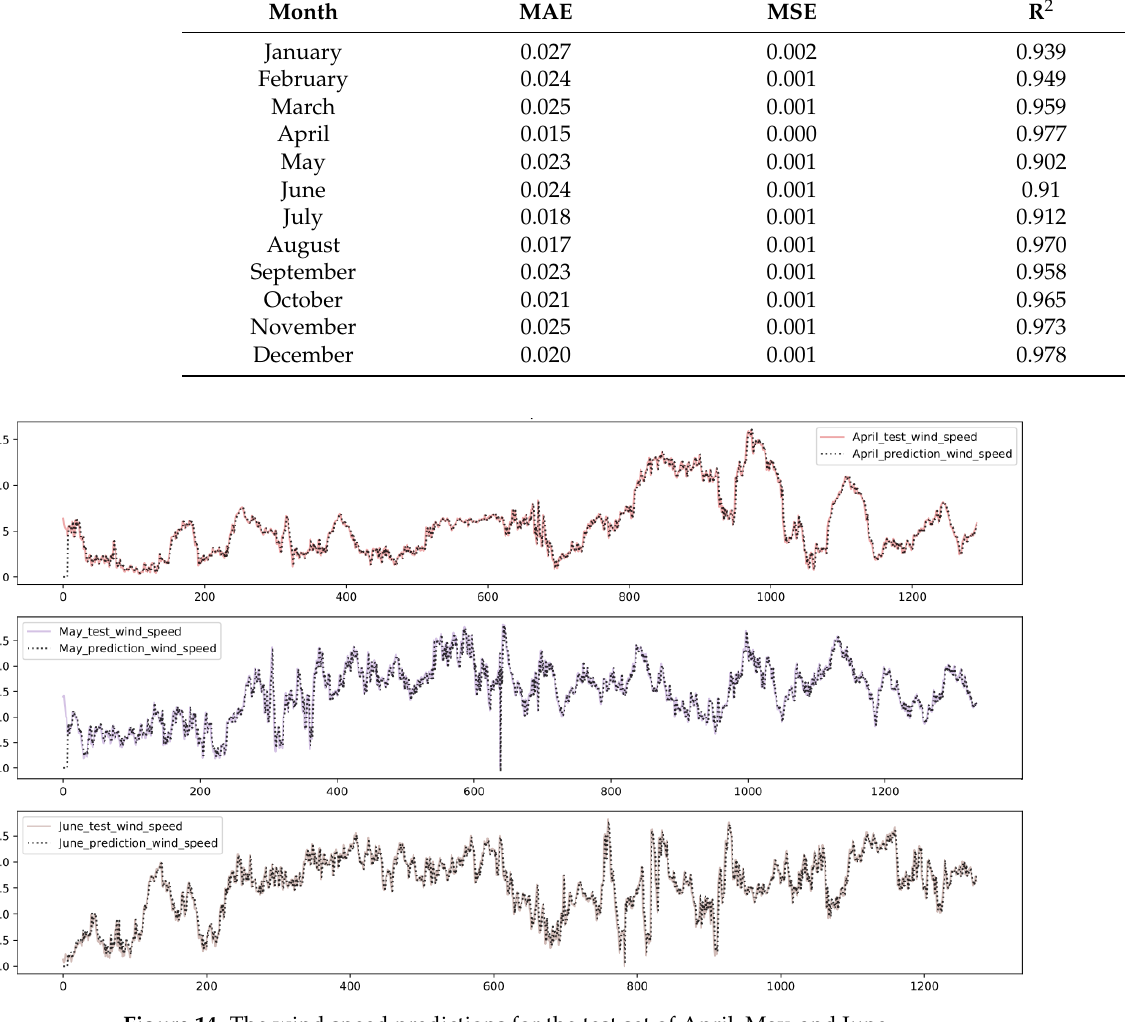
Figure 14. The wind speed predictions for the test set of April, May, and